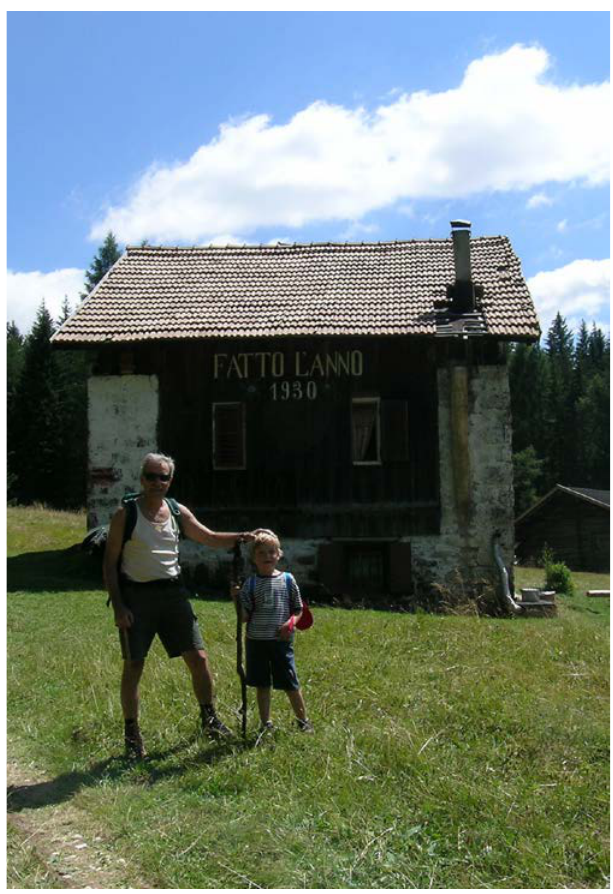
Figure 5 – Mountain building with the writing ‘FATTO L’ANNO’. Photo by Marta Bazzanella. Courtesy of Museo degli Usi e Costumi della Gente